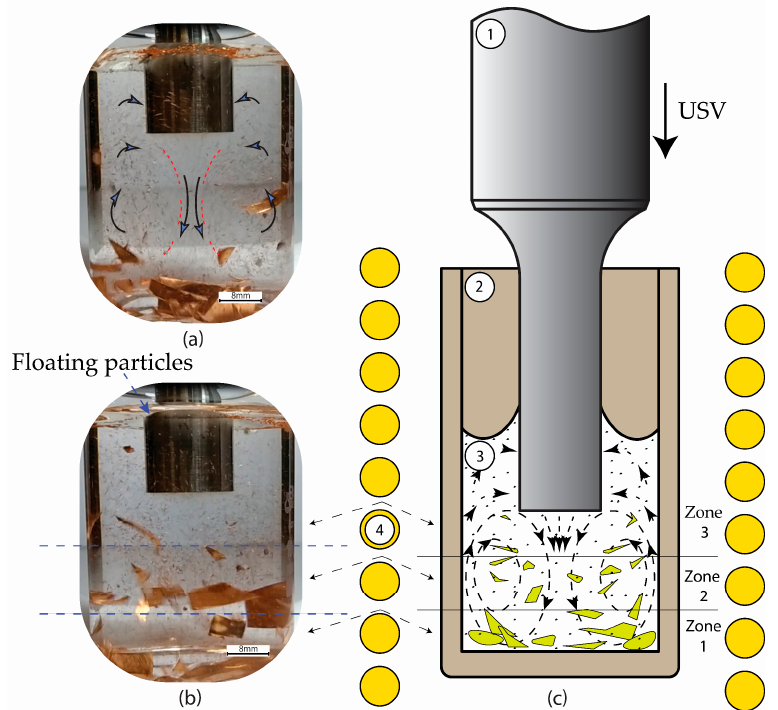
Figure 5. ( a ), ( b ) USV in water with amount of Cu segments/particles. ( c ) Suggested schematic diagram of the USV process in the melt based on ( a ) and ( b ). Cu segments distributed